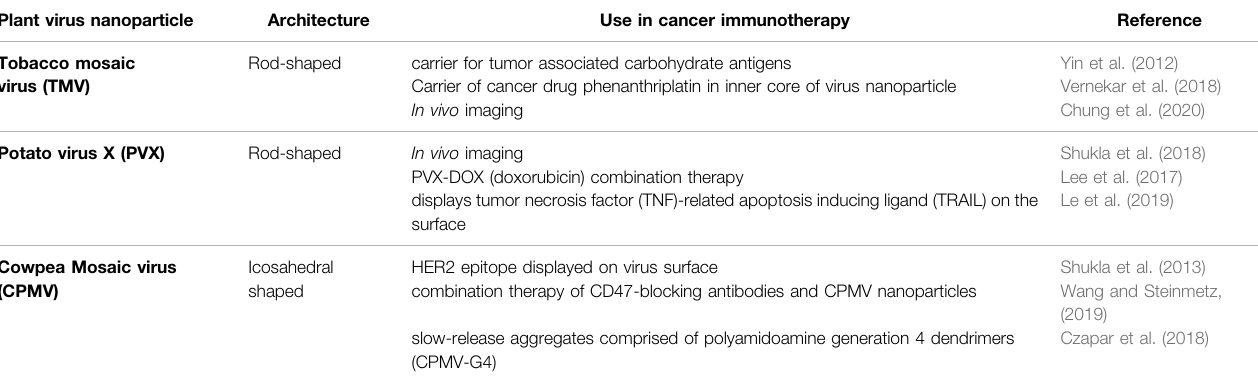
TABLE 1 | Select Examples of Plant Virus Nanoparticles and their Medical Applications. Plant virus